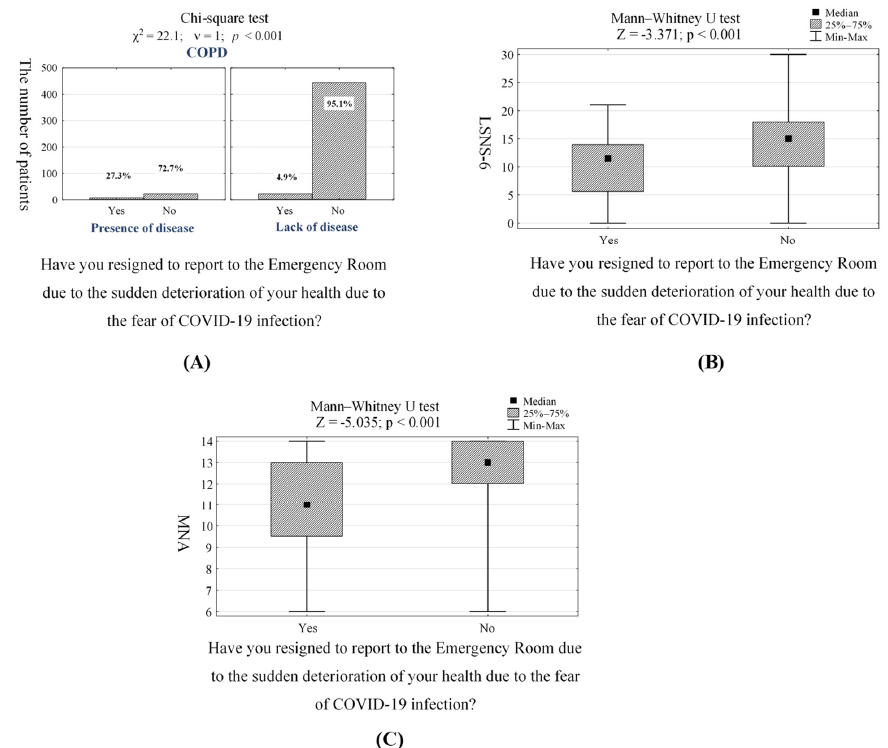
Figure 2. ( A ) Number ( n ) and percentage (%) of elderly patients who resigned to report to the Emergency Room due to the fear of COVID-19 infection in groups differing in those suffering from COPD or not; responses to the question regarding the resignation of reporting to the Emergency Room due to the fear of COVID-19 infection in feeling lonely patients ( B ) and patients with malnutrition ( C ) and the results of independent, non-parametric, significance Table 4. Results of univariate and multivariate logistic regression of the answer to the question